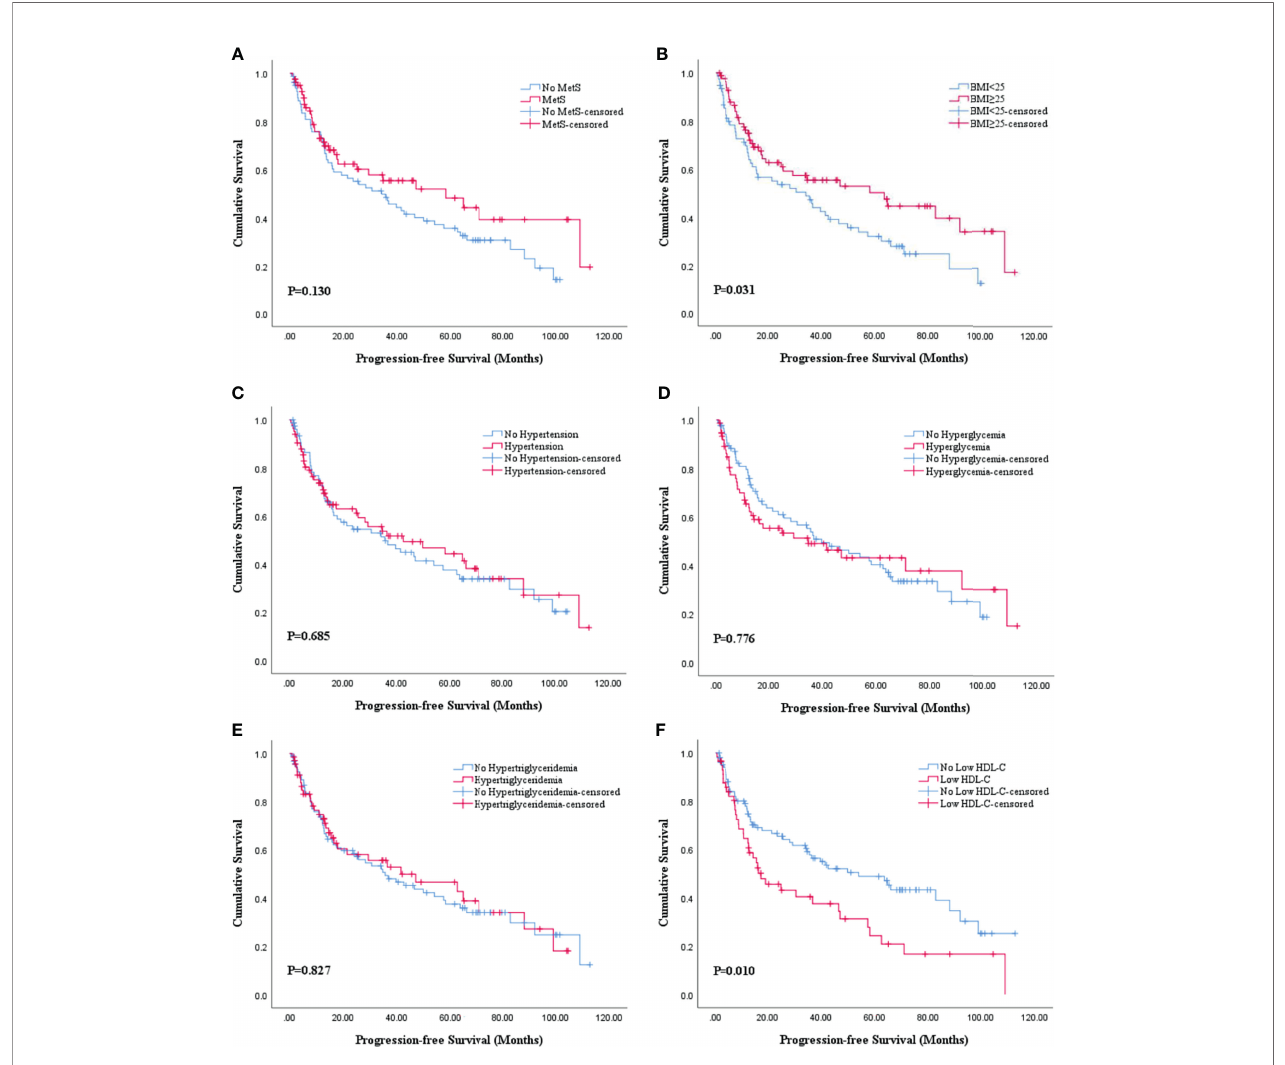
FIGURE 3 | Kaplan-Meier survival analysis of PFS strati fi ed by MetS and its components after PSM. (A) MetS and non-MetS; (B) BMI <25 and BMI ≥ 25; (C) hypertension and no hypertension; (D) hyperglycemia and no hyperglycemia; (E) hypertriglyceridemia and no hypertriglyceridemia; (F) low HDL-C and no low HDL-C. BMI, body mass index; HDL-C, high density lipoprotein cholesterol; MetS, metabolic syndrome; PFS, progression-free survival; PSM, propensity score